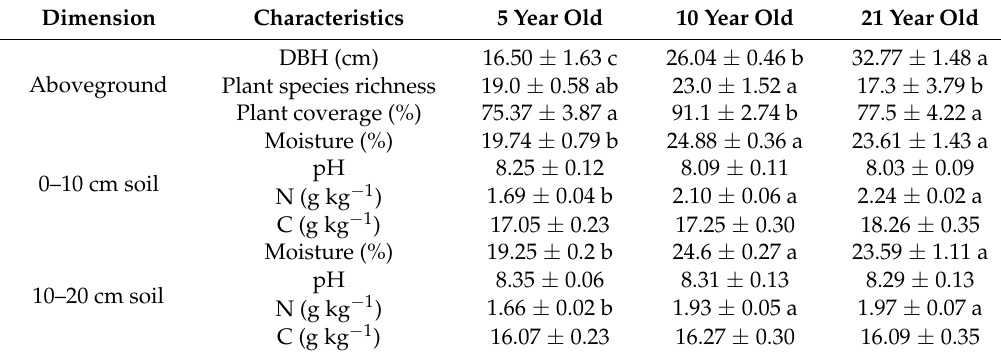
Table 4. Stand characteristics ( n = 3) along an age chronosequence of poplar plantations in a coastal region of Eastern China.